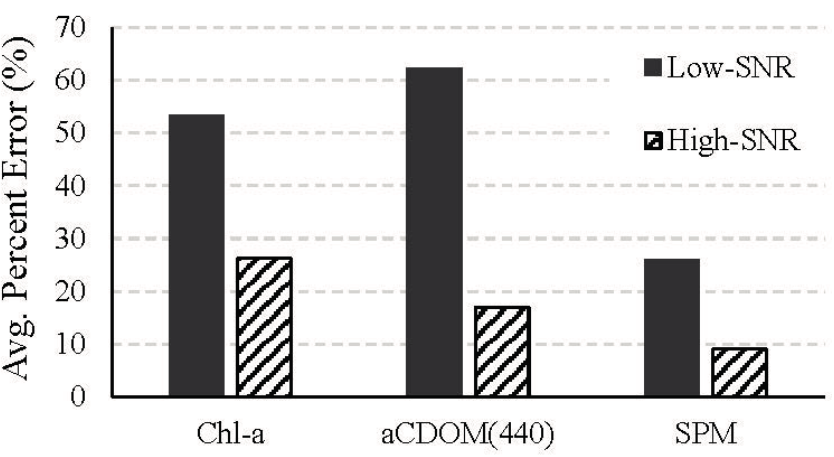
Figure 9. The average percent errors for the low- and high-SNR systems in the concentrations of chl- a and SPM and a CDOM (440) retrieved from the 20 atmospherically corrected noisy images using the non-linear least squares error minimization approach (ii) Semi-Analytical NIR-red